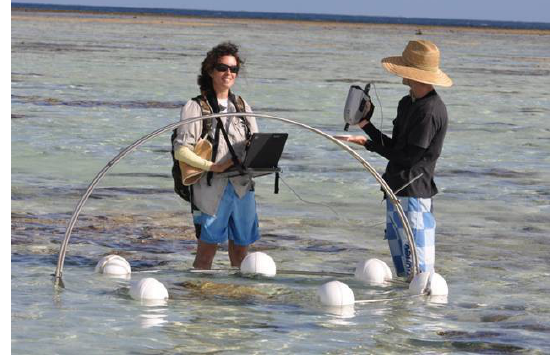
Figure 1. Field data collection - Heron